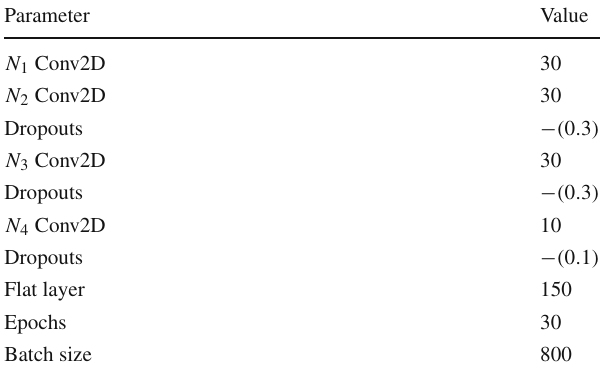
Table 5 CNN architectures used for truth and reco